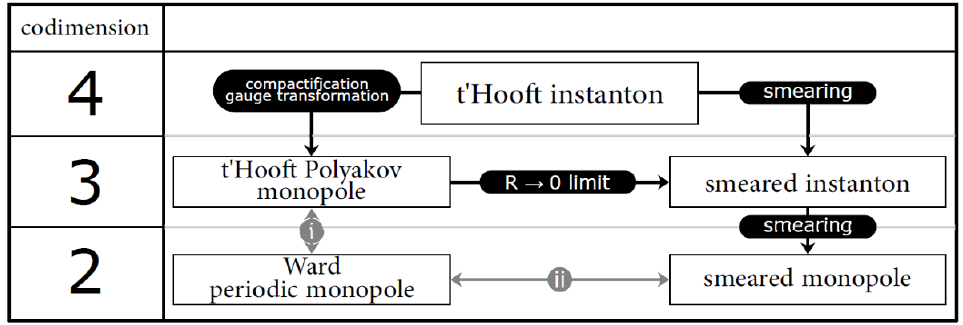
Figure 3 . The relationships among (cid:12)ve-branes of various